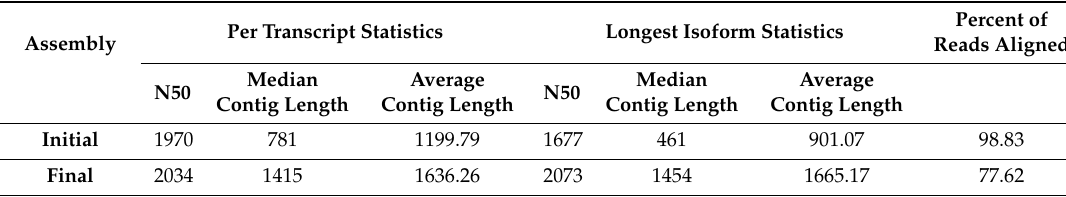
Table 1. Assembly statistics of seed transcriptomes.